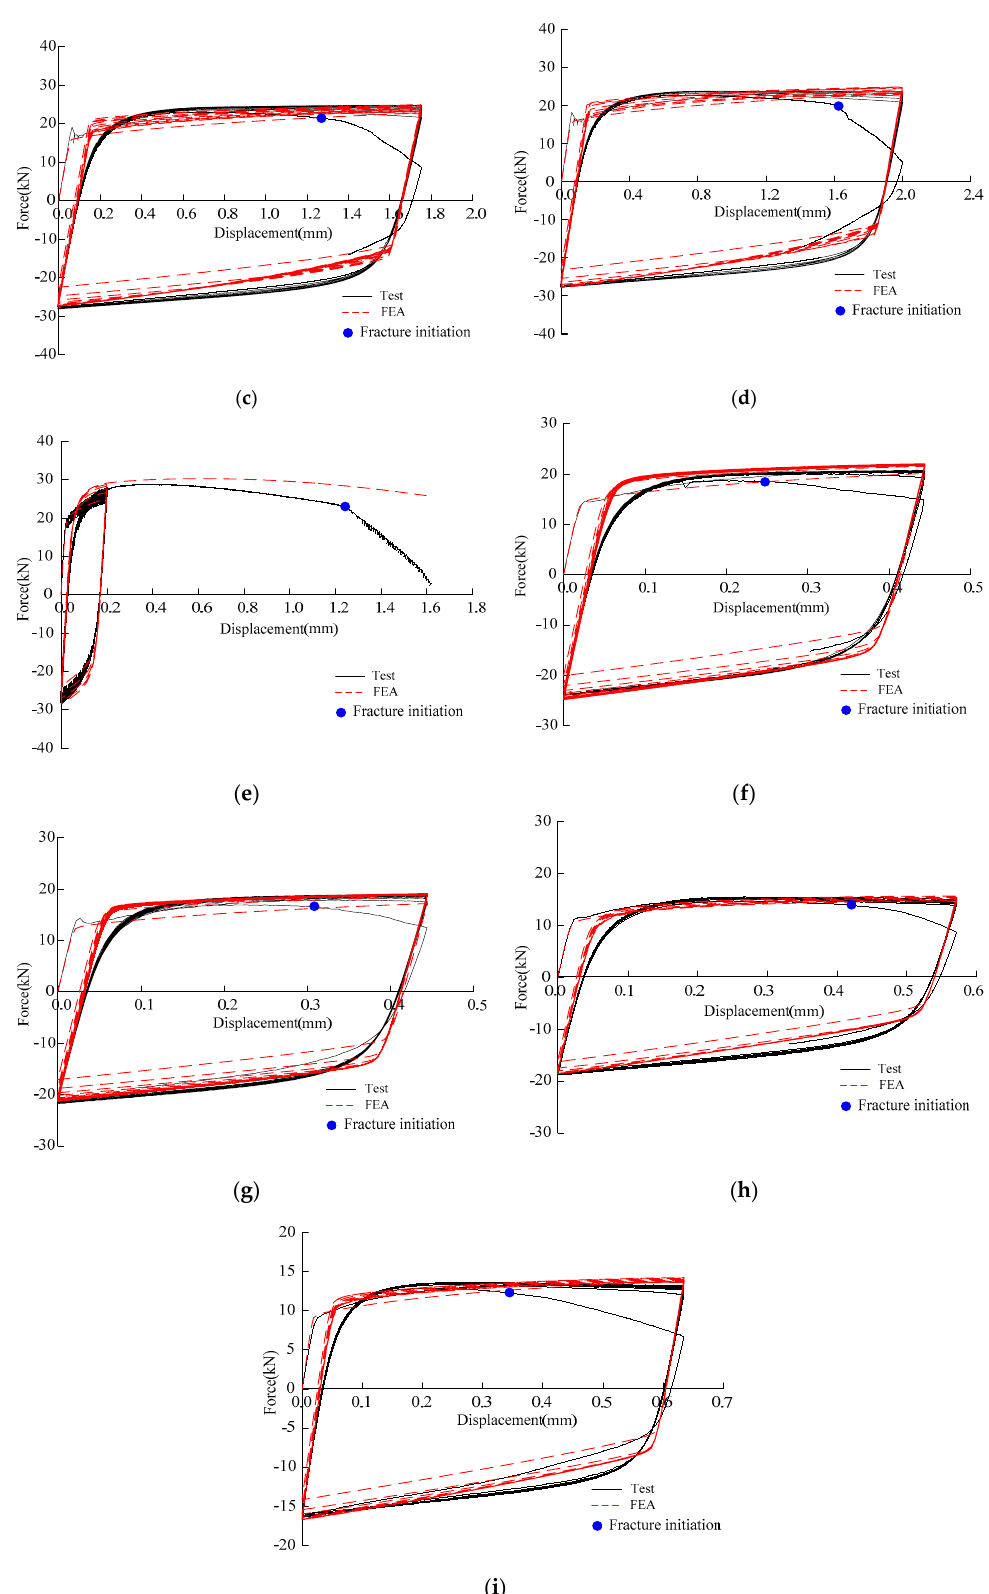
Figure 8. Comparison of force-displacement of specimens obtained by tests and FEA: ( a ) BMC-1; ( b ) BMC-3; ( c ) BMC-5; ( d ) BMC-7; ( e ) BMC-9; ( f ) BMC-11; ( g ) BMC-13; ( h ) BMC-15; ( i )